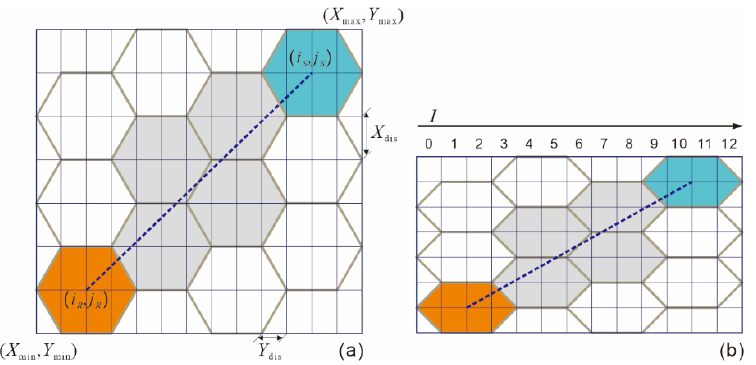
Figure 9. The grid determination method by using a simple modification of the Bresenham algorithm: ( a ) Regular hexagonal grid divided into rectangular grids, ( b ) Rectangular grid regularization.